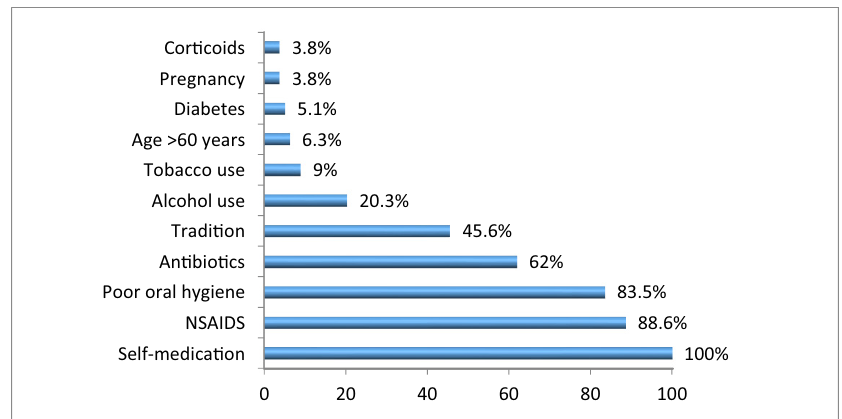
Fig. 3. Risk factors for dental